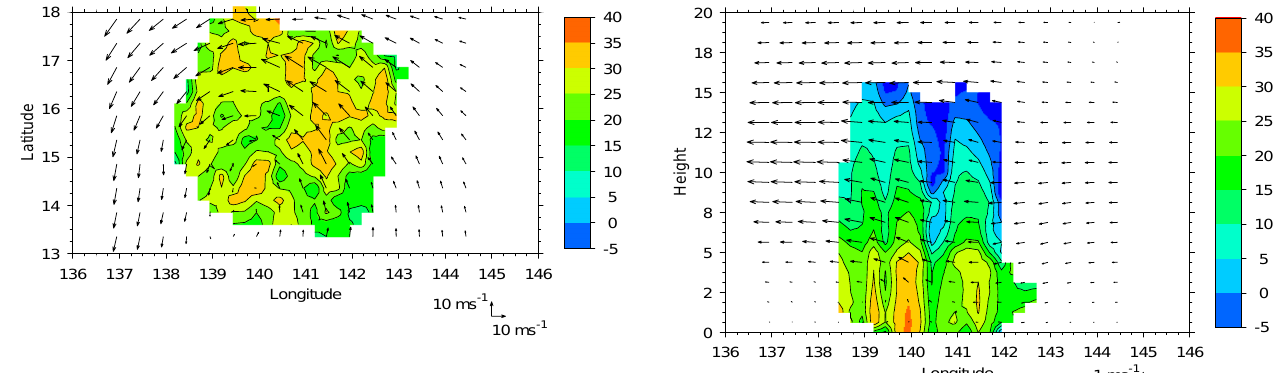
Fig. 8. Results of the retrieval using radar data only. A horizontal plan view at a height of 1.875km is displayed. The arrows show the projection of the Earth-relative wind field, while colors and contours show the reflectivity field. The scales for the zonal and meridional winds are indicated at the bottom of the plot. Contours are shown every 5dbz.